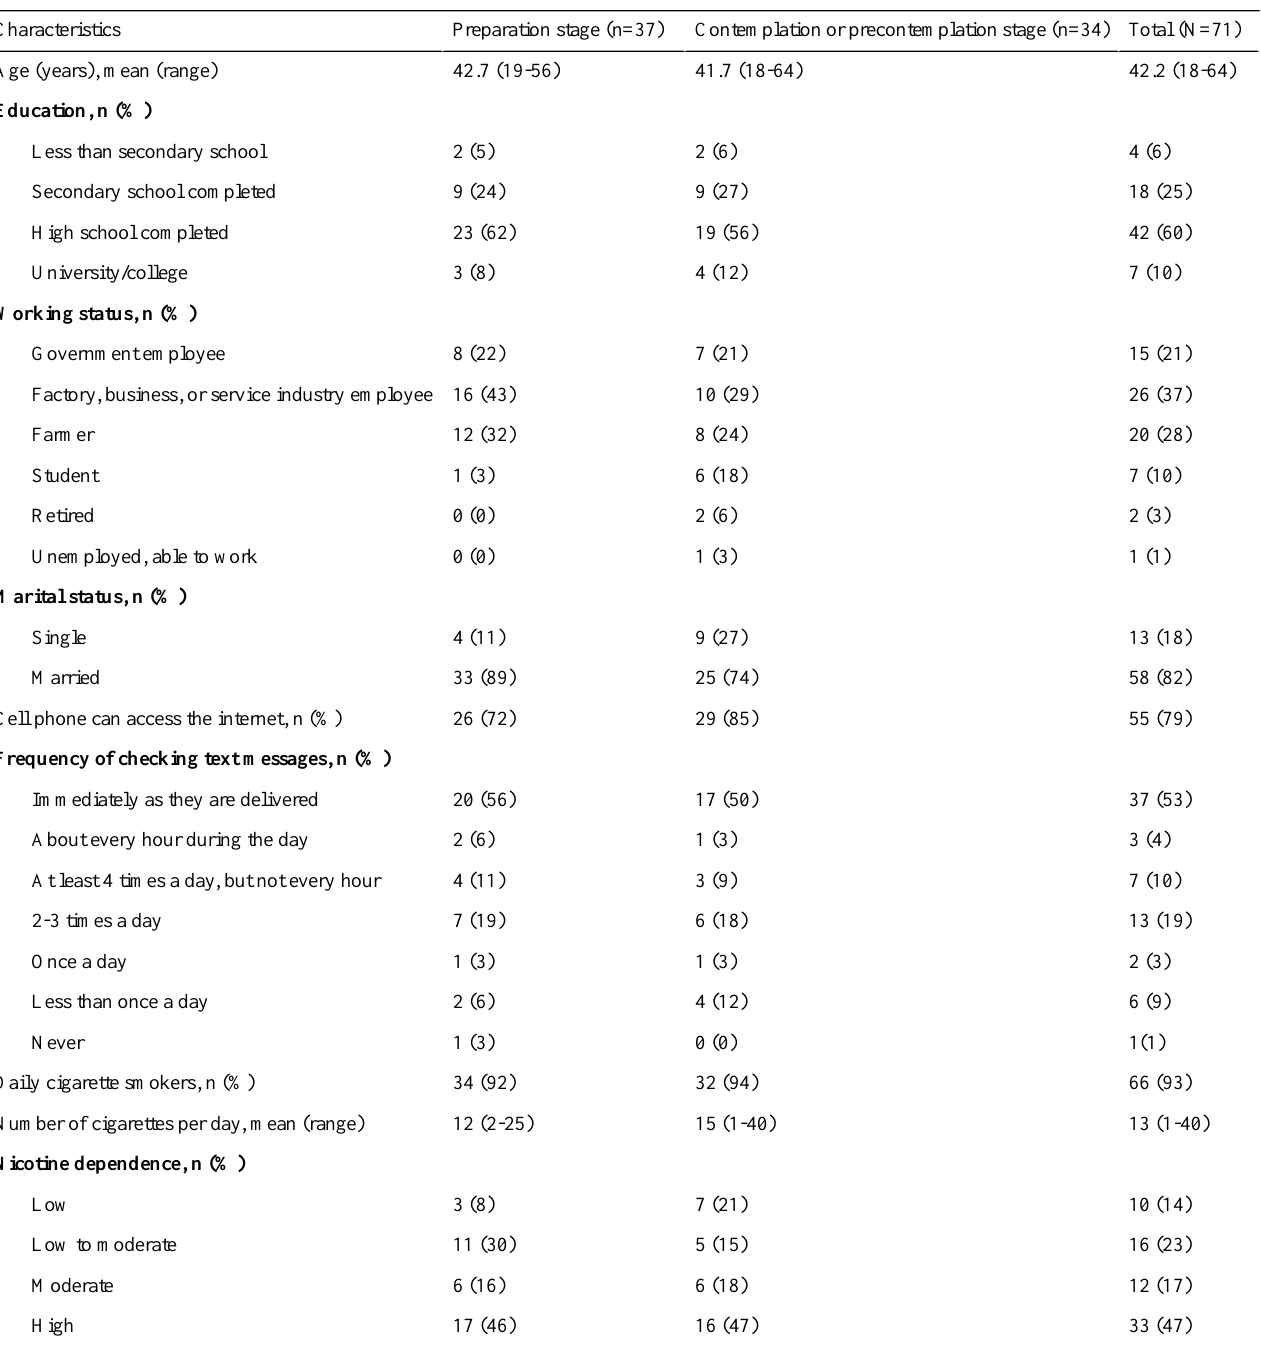
Table 1. Participant